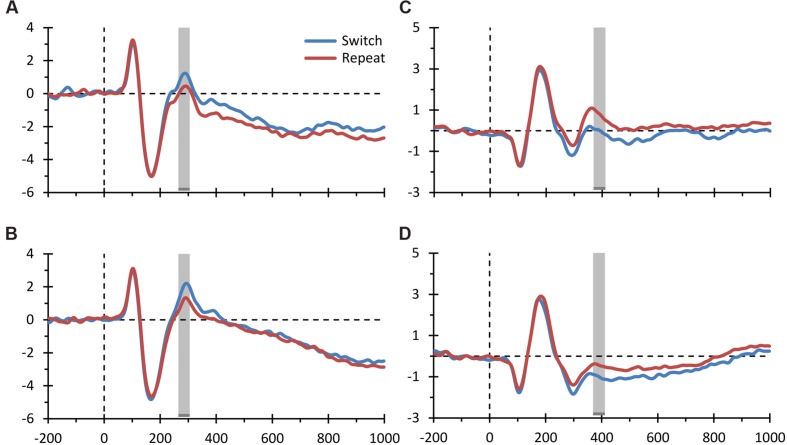
Event-related potential (ERP) switch effects for the spatial and verbal domains. The figure displays the grand average ERPs elicited by switch and repeat trials plotted separately for the spatial and verbal domains for both the parieto-occipital ERP switch effect (A,B depict the spatial and verbal domains, respectively) and the frontal ERP switch effect (C,D depict the spatial and verbal domains, respectively) shown in Figures 3B,C. The conventions are the same as those of Figure 3.